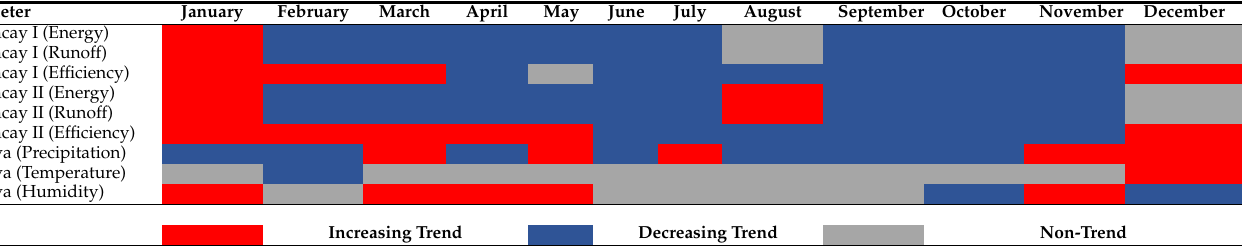
Figure 6. IPTA Method Graphs of Arithmetic Mean Analysis Results of Sakarya Province. Table 2. General Evaluation of Arithmetic Mean Analysis Results for Each Parameter.